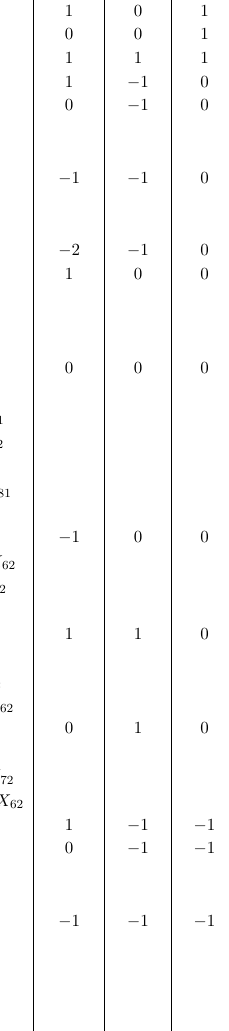
Table 33 . The generators in terms of bifundamental chiral fields for Model 8 (Part 1)